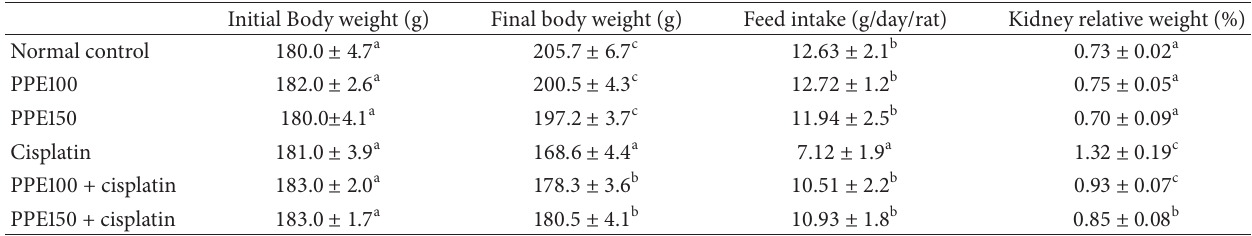
Table 2: Effect of Physalis peruviana L. extract on body weight, feed intake, and kidney relative weight in normal and cisplatin induced ARI rats.